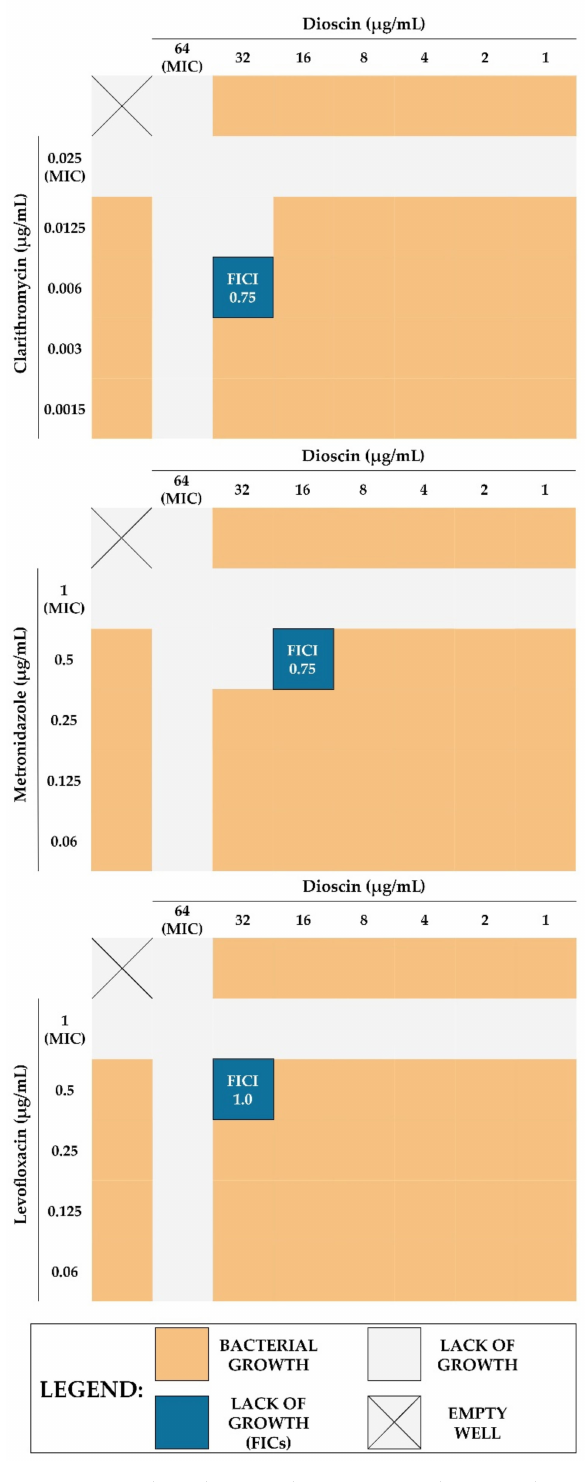
Figure 7. Graphics showing the interactions between dioscin and the three classically used antibiotics (clarithromycin [CLR], metronidazole [MTZ], and levofloxacin [LEV]) in antibacterial activity against H. pylori J99. Interactions were determined using the checkerboard assay. FICI values of ≤ 0.5, > 0.5 to ≤ 1, and > 1 to ≤ 4 were expressed as synergistic, additive, and neutral,